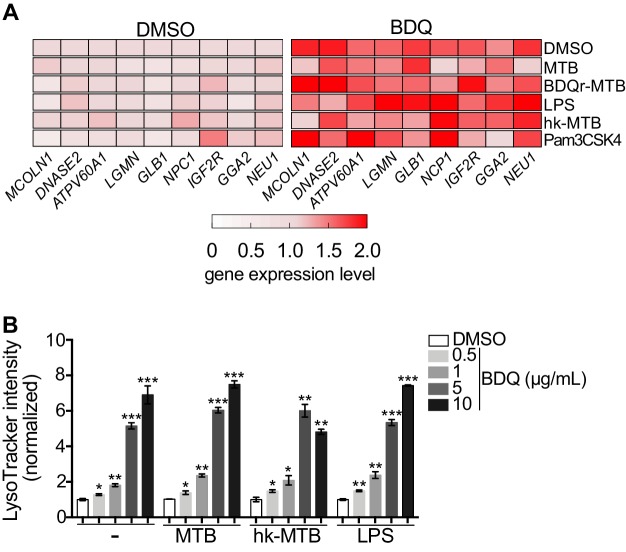
BDQ activates the lysosomal pathway, regardless of infection with live MTB.(A) Briefly, cells were untreated, infected with drug-susceptible MTB or BDQr-MTB, or stimulated with LPS (TLR4 agonist), Pam3CSK4 (TLR1/2 agonist) or heat-killed bacteria, and then treated with BDQ. After 18 hr, RNA was collected and RT-qPCR performed on a panel of lysosomal genes. (B) Control, drug-susceptible MTB infected macrophages and cells stimulated with LPS or hk-MTB, were treated with BDQ and then stained with LysoTracker. Fluorescence intensity was analyzed by flow cytometry. Error bars represent the mean ± SD and significant differences between treatments are indicated by an asterisk, in which *p<0.05, **p<0.01, ***p<0.001.